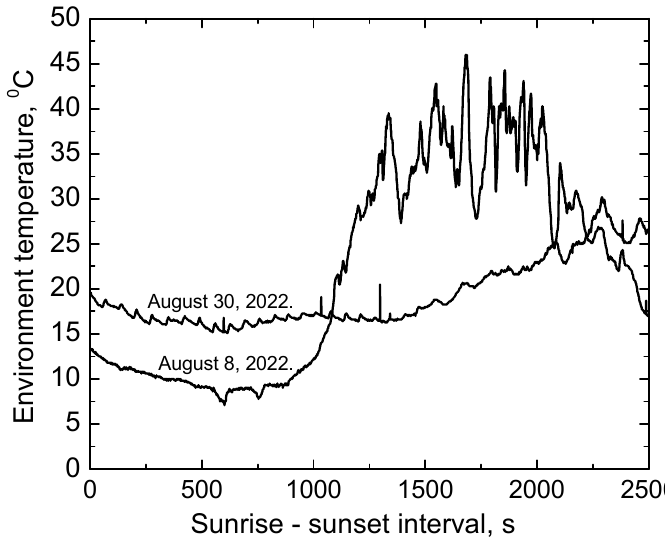
Figure 11. Surface temperature fluctuations of solar battery between sunrise and sunset.